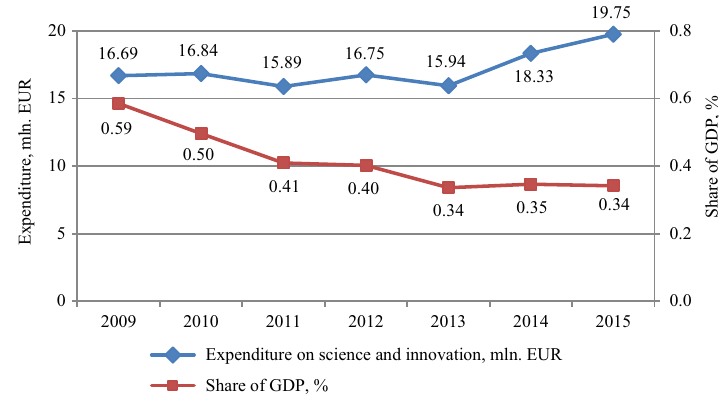
Fig. 2. Evolution of state budget financing of science and